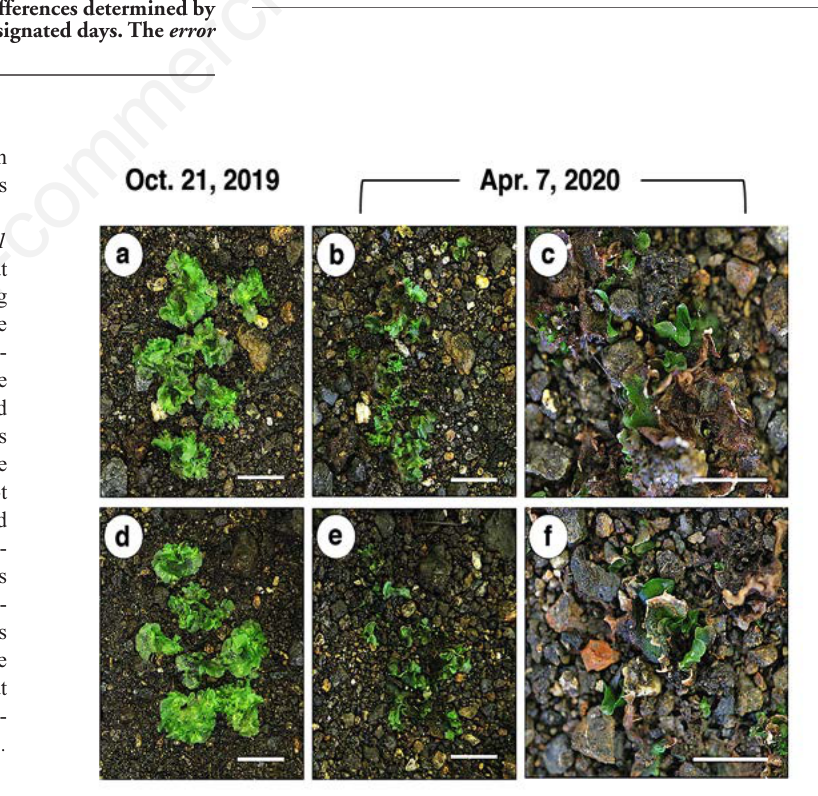
Figure 4. Wild-type (a–c) and Aypad1 (d–f) gametophytes grown on soil collected from mine tailings areas where A. yokoscense had grown in colonies. Bar = 5